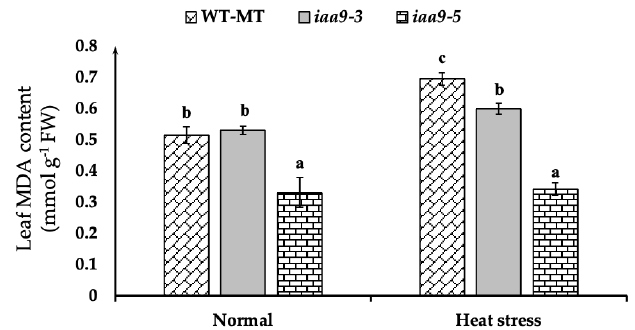
Figure 5. Leaf MDA content of WT-MT, iaa9-3 , and iaa9-5 under normal and heat stress conditions. The average value ± standard error (SE) ( n = 4) followed by the same letter is not significantly different according to the Tukey-HSD test at 5%.